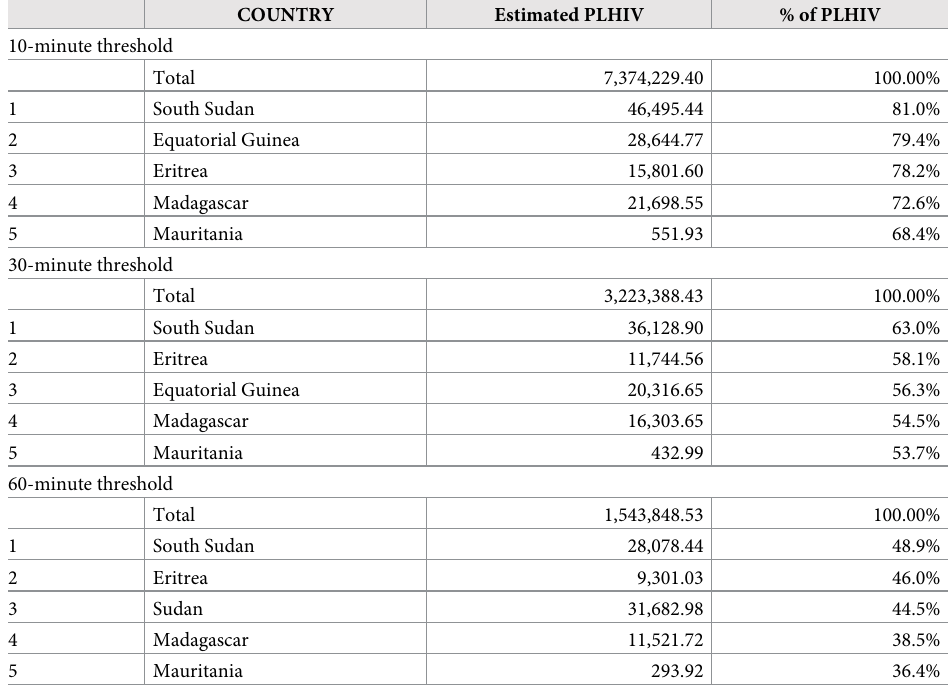
Table 1. The top five countries in sub-Saharan Africa with the highest number (%) of People Living with HIV (PLHIV) who cannot access health care facilities within thresholds by motorized transportation in 2017. COUNTRY Estimated PLHIV % of